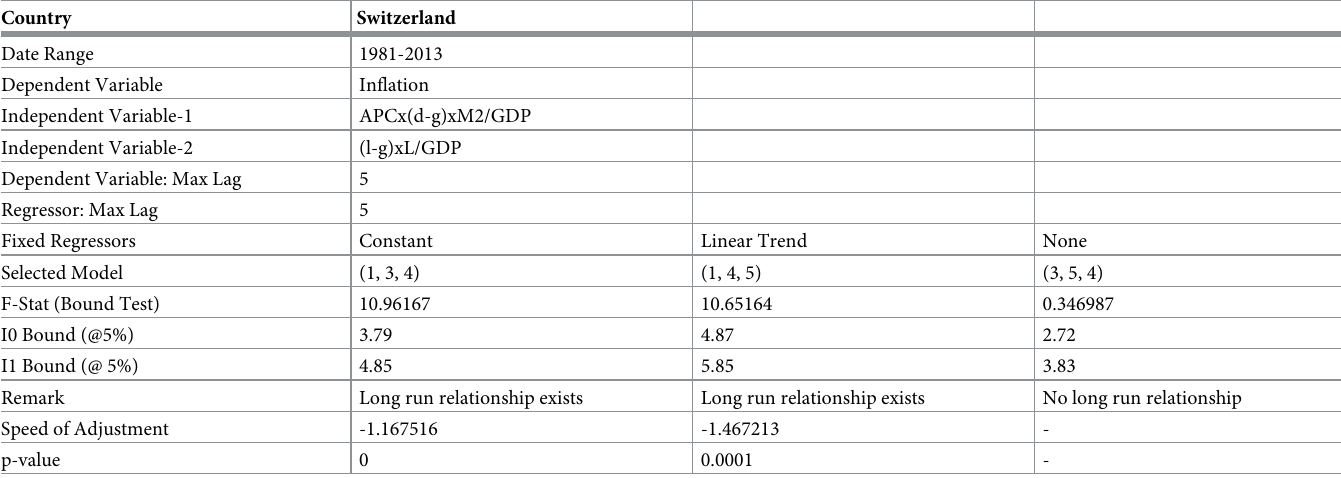
Table 24. ARDL Bounds Testing for Swiss data under proposed framework.